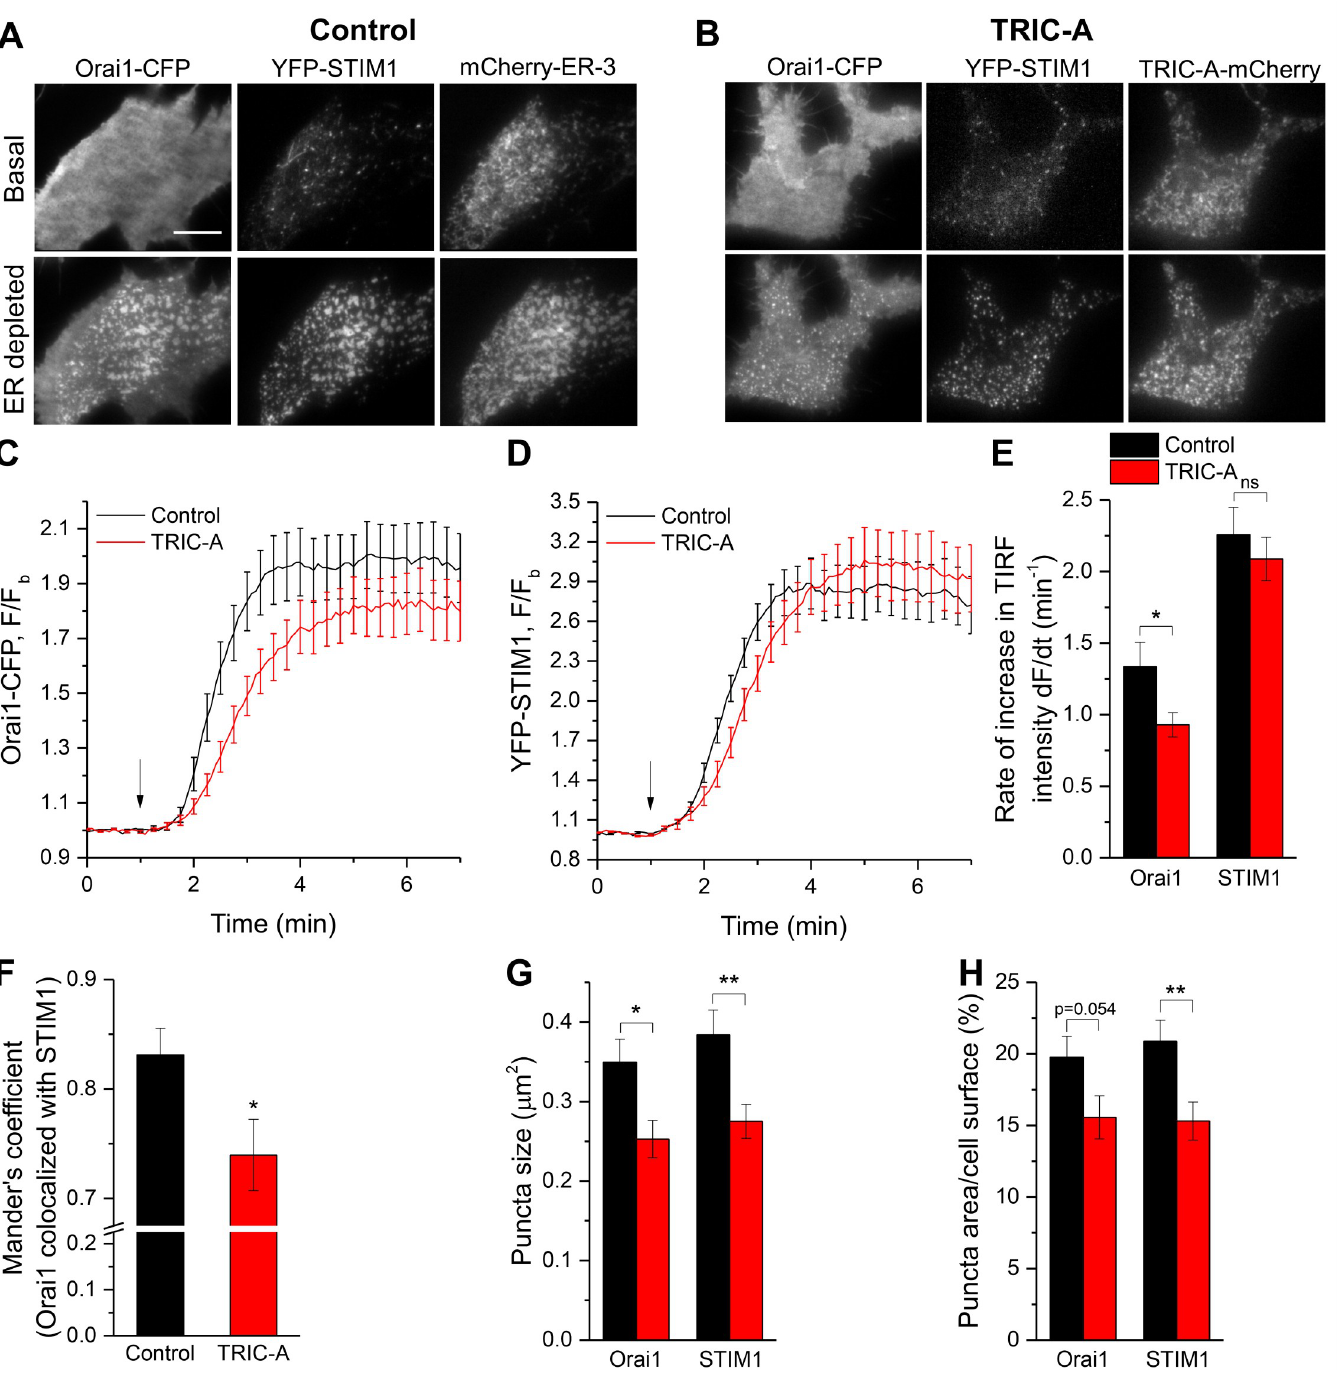
Fig 6. TRIC-A affects kinetics and extent of STIM1-Orai1 puncta formation upon store depletion. (A, B) TIRF images of basal (top) and ER-depleted (100 μ M CCh + 30 μ M BHQ) (bottom) cell expressing Orai1-CFP (left, Orai1) and YFP-STIM1 (middle, STIM1) along with mCherry-ER-3 (right) (A, control) or TRIC-A-mCherry (right) (B, TRIC-A). Scale bar = 10 μ m. (C, D) Traces show kinetics of Orai1-CFP and YFP-STIM1 TIRF intensity upon ER depletion (arrow) in TRIC-A (+) cells versus controls ( n = 18 each). (E) Rate of increase in Orai1 and STIM1 TIRF intensity upon ER depletion shown in (C, D). (F) Mander’s coefficient showing proportion of Orai1 colocalized with STIM1, (G) average puncta size ( μ m 2 ), and (H) puncta area relative to cell surface area (%) of Orai1 and STIM1 in TRIC-A (+) cells versus controls. � p < 0.05, �� p < 0.01; mean values ± SEM are shown. Underlying data in panels (C–H) are included in S1 Data. BHQ, 2,5-Di- t -butyl-1,4-benzohydroquinone; CCh, carbachol; CFP, cyan fluorescent protein; ER, endoplasmic reticulum; Orai1, Ca 2+ -release–activated Ca 2+ channel 1; STIM1, stromal interaction molecule 1; TIRF, total internal reflection fluorescence; TRIC, trimeric intracellular cation; YFP, yellow fluorescent protein.